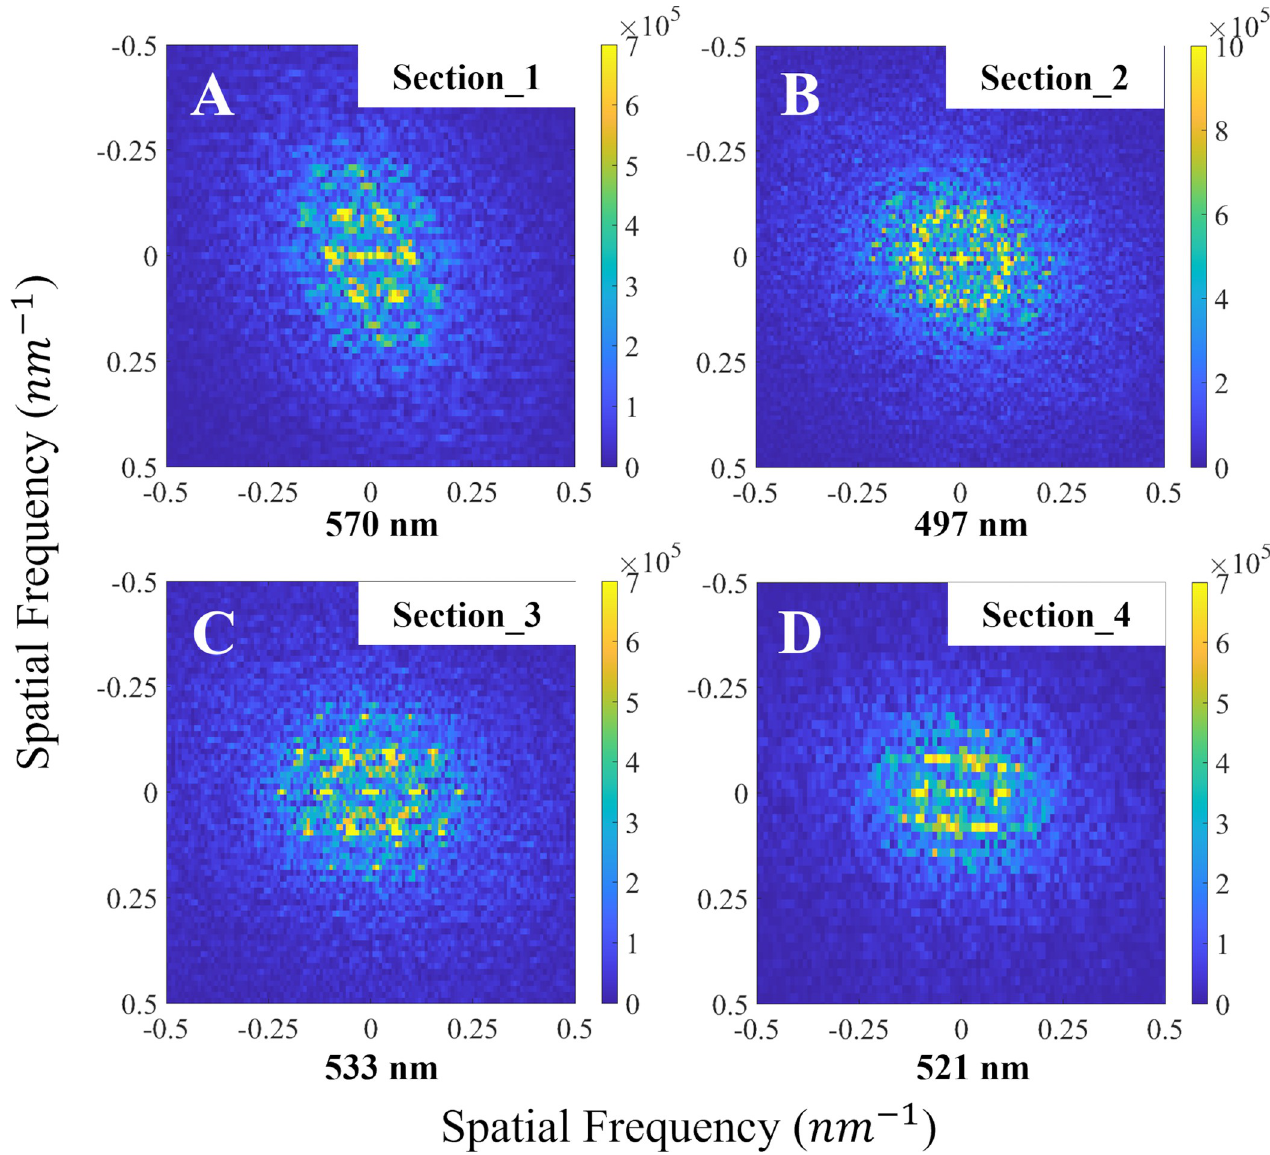
Fig 5. Fourier transforms for the sections from a single-barbule TEM image. The Fourier transforms for the refractive index distribution in the barbule are expressed in spatial frequency. The peak wavelengths predicted from Fourier analysis are listed under each image.